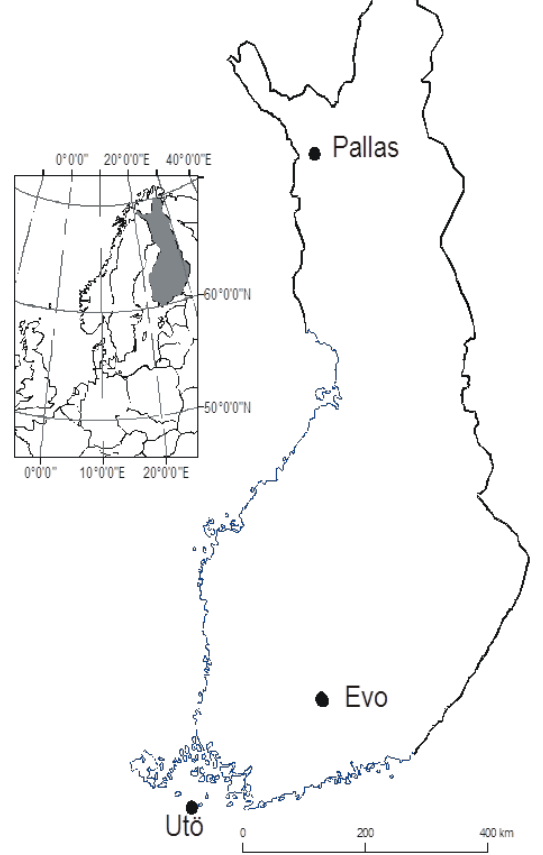
Figure 1. The map of Finland and the regions of Pallas, Evo, and Utö.